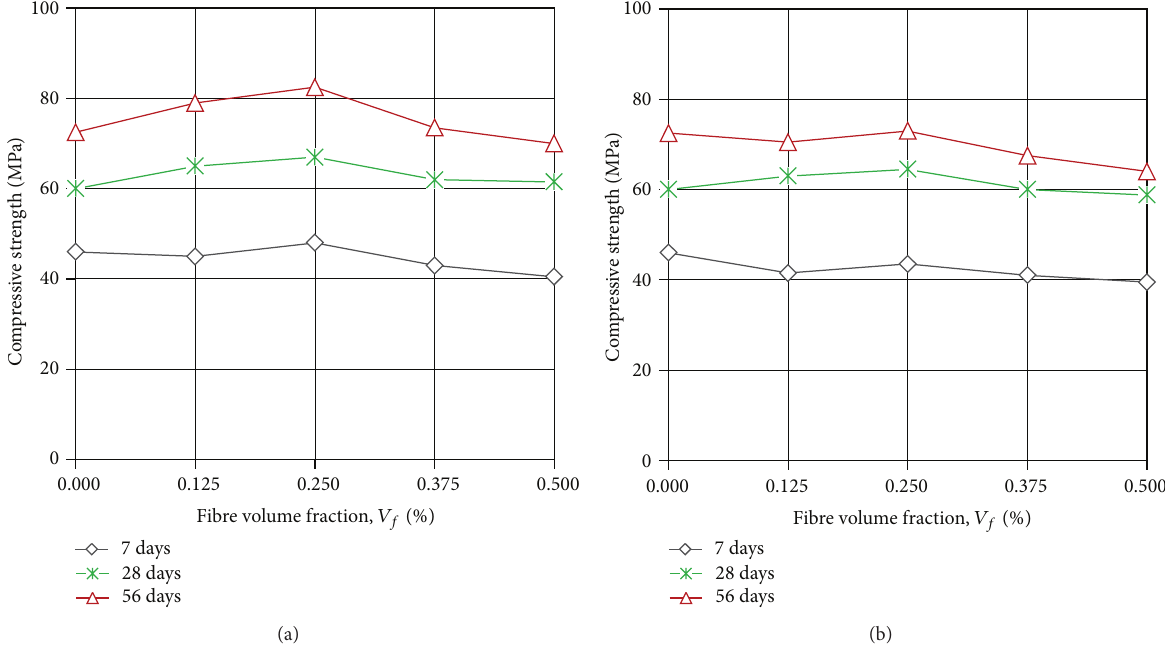
Figure 5: Compressive strength versus fibre content at 7, 28, and 56 days; FRC with 6mm fibres (a) and FRC with 12mm fibres